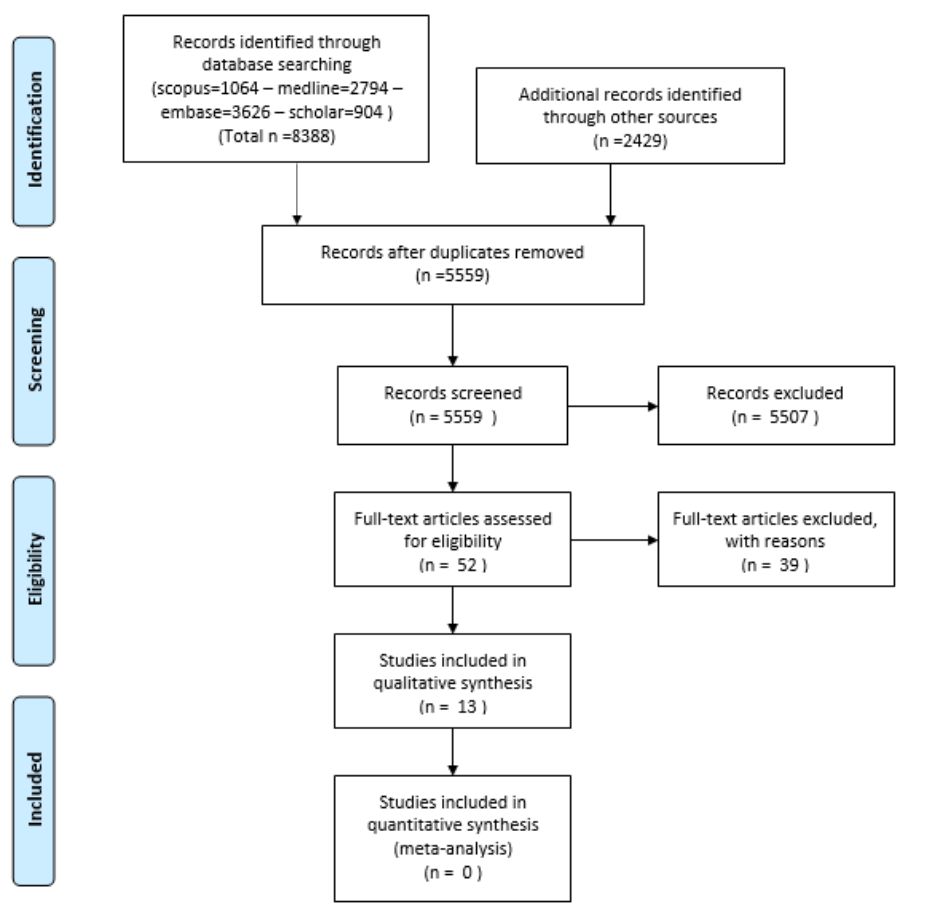
Figure 1. PRISMA Flowchart of analysed Figure 1: PRISMA Flowchart of analysed studies